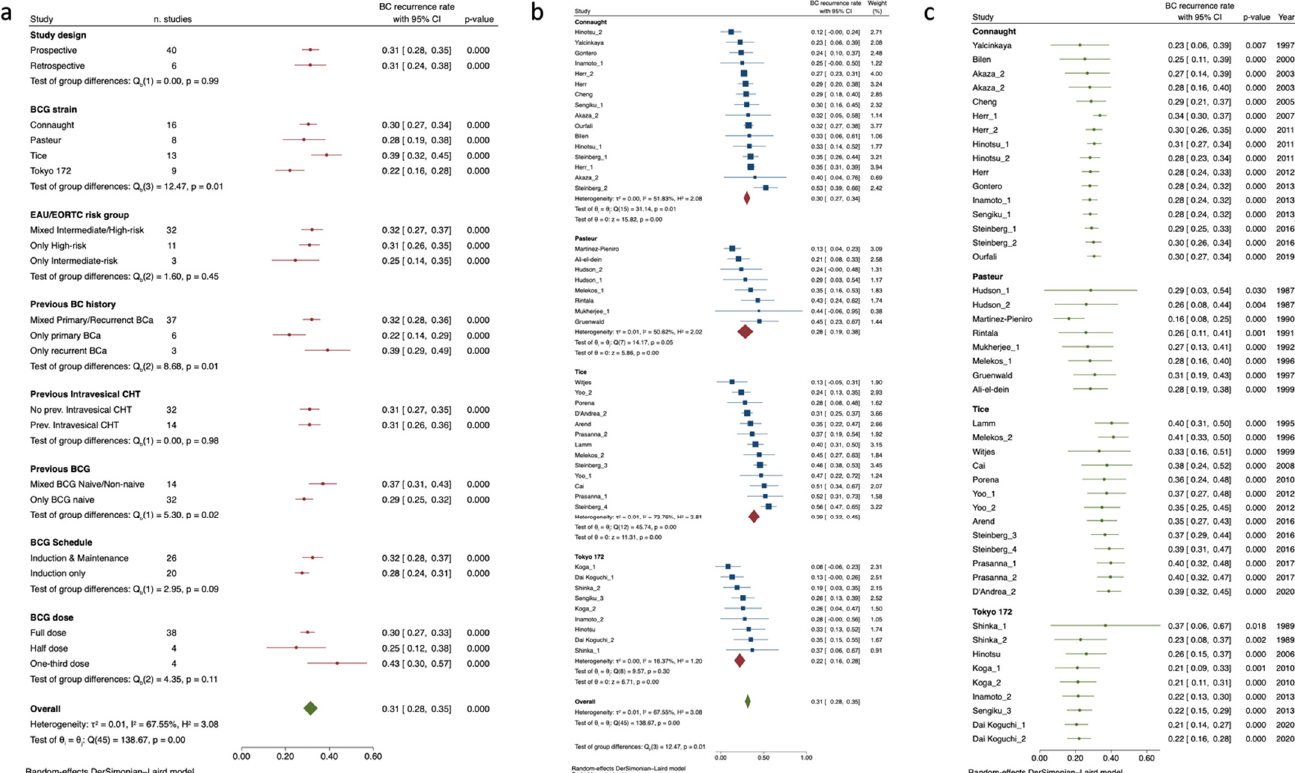
Figure 2. Sub-groups analysis for BC recurrence rate by studies with >3-y RFS endpoints exploring heterogeneity according to categorical confounders (e.g., study, BCG, and NMIBC characteristics) ( a ). Forrest plot depicting BC recurrence rate by studies with >3-y RFS endpoints grouped by BCG strains and sorted by increasing effect size ( b ). Forrest-plot for cumulative meta-analysis by studies with >3-y RFS endpoints grouped according to BCG strain and sorted by year of publication ( c ). BC: Bladder Cancer; BCG: Bacillus Calmette–Guérin; Bladder Cancer; CHT: Chemotherapy; EAU: European Association of Urology.